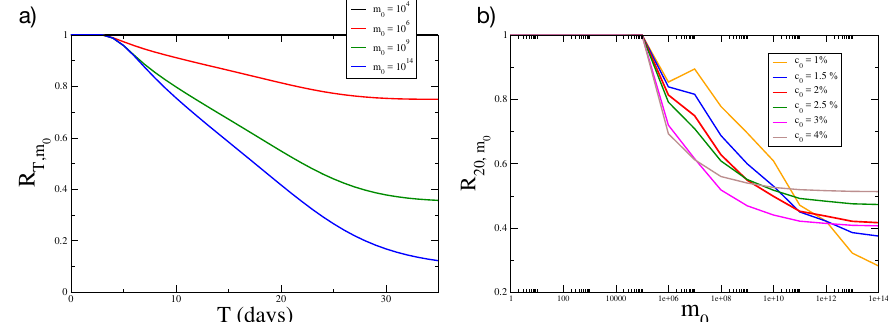
Figure A2. ( a ) The quantity R T , m for 2 10 5 sorted cancer cells as a function of T for different choices 0 × of m 0 . ( b ) The same quantity plotted in ( a ),but assuming different possibilities for c 0 and making the experiments at T = 20 days.